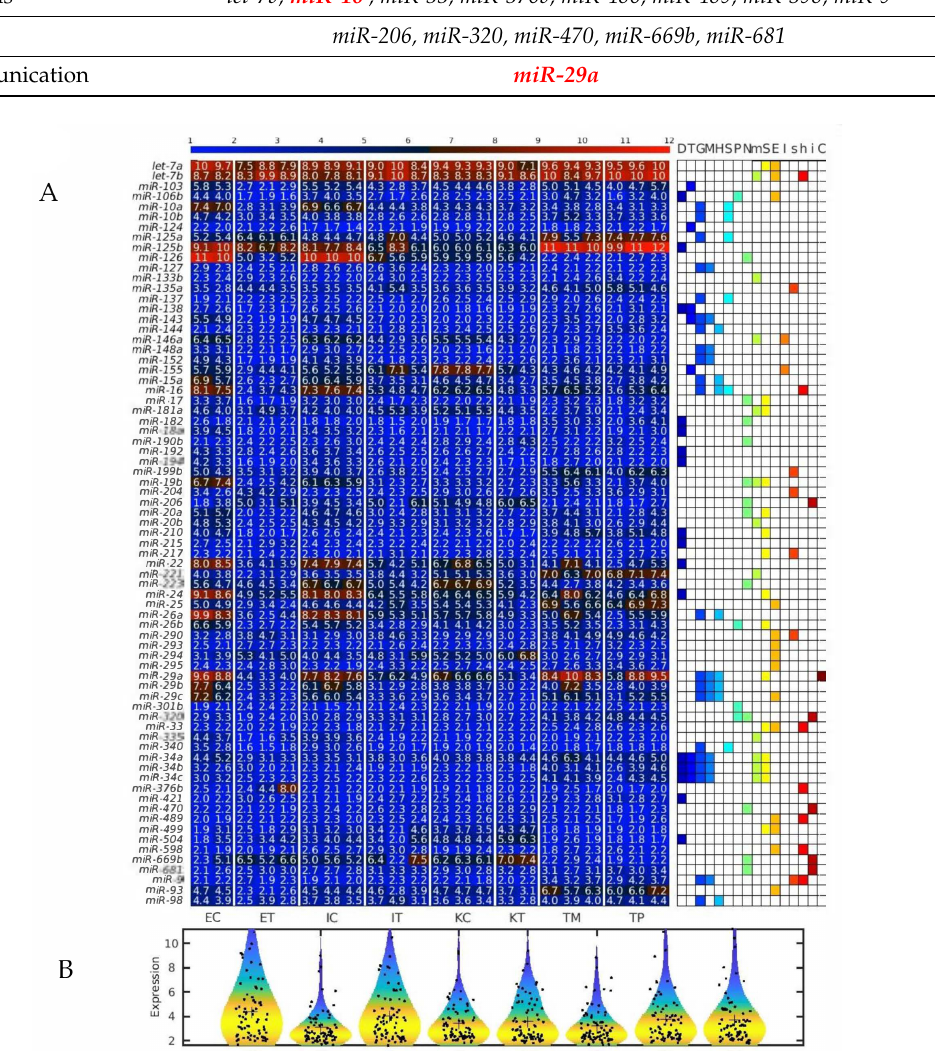
Figure 6. Several microRNAs (miRNAs) downregulated simultaneously in the three types of tumor microenvironment (TME) cells are hallmarks of eukaryotic aging. ( A ) Heatmap of all geromiRs and their annotation with different aging hallmarks. D: altered DNA damage response, T: loss of telomeres, G: changes in gene regulation, M: DNA methylation, H: histone modifications, S: regulation of